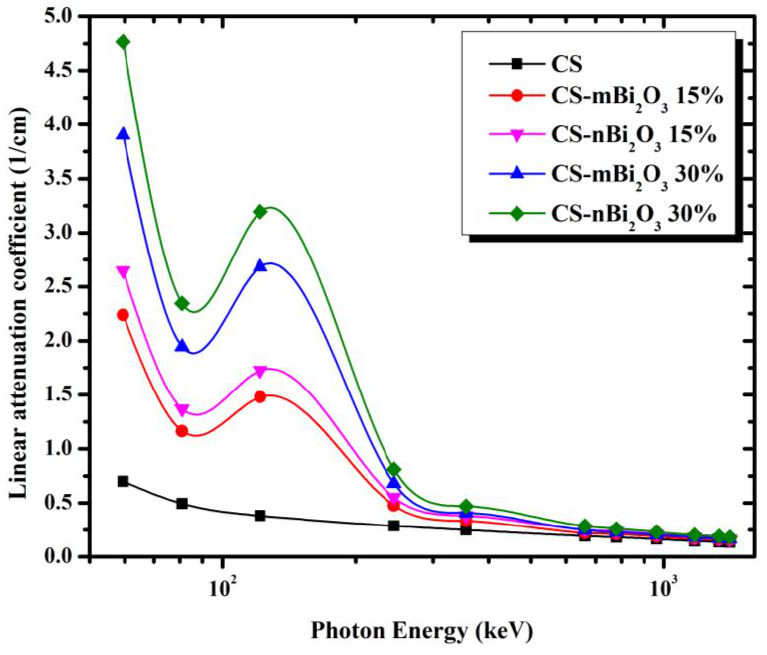
Figure 4. The linear attenuation coefficient of all mortar samples as a function of the photon energy (MeV).